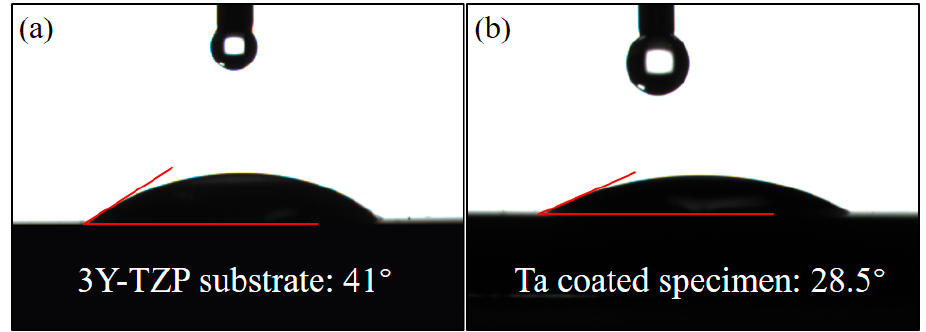
Figure 5. The water contact angle of ( a ) uncoated 3Y-TZP substrate and ( b ) Ta coated specimen.